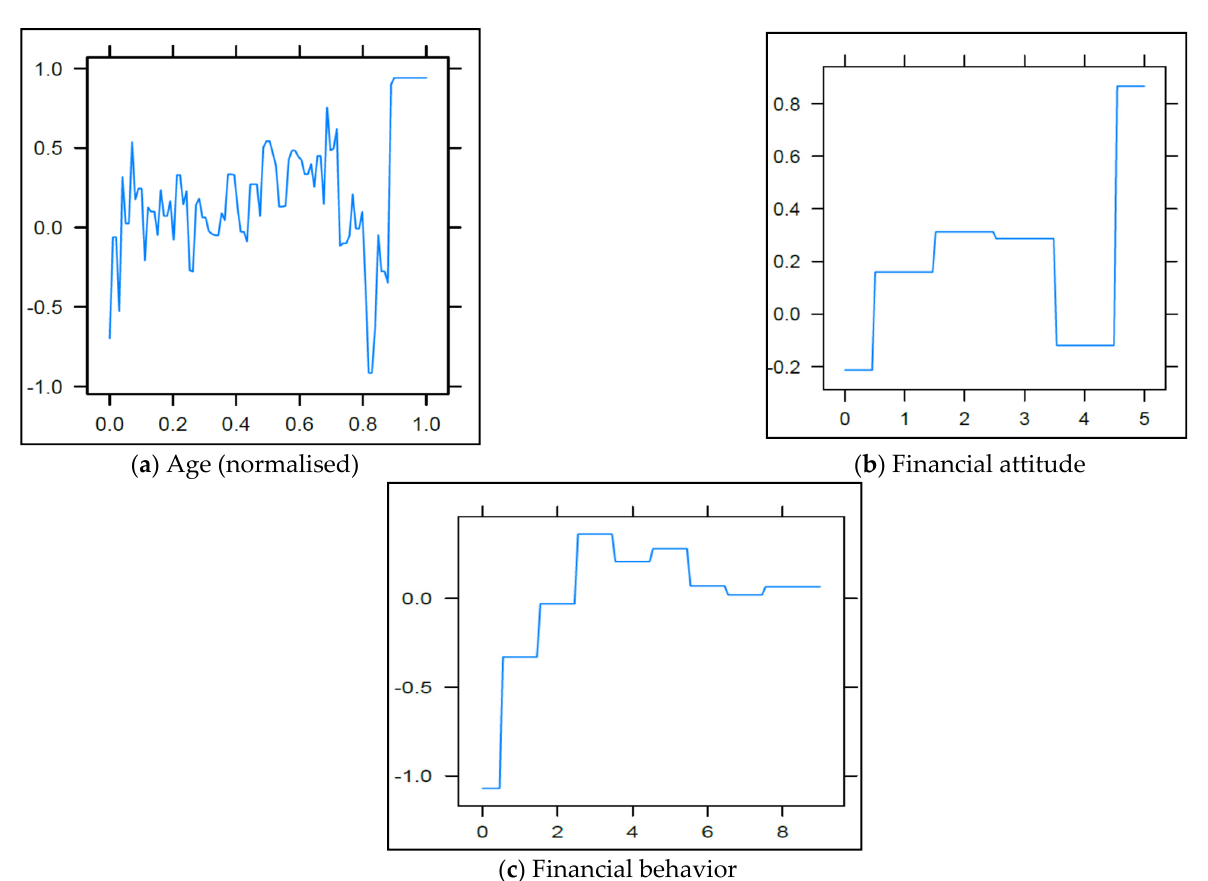
Figure 5. Single variable partial dependence plots for the three most important predictors.